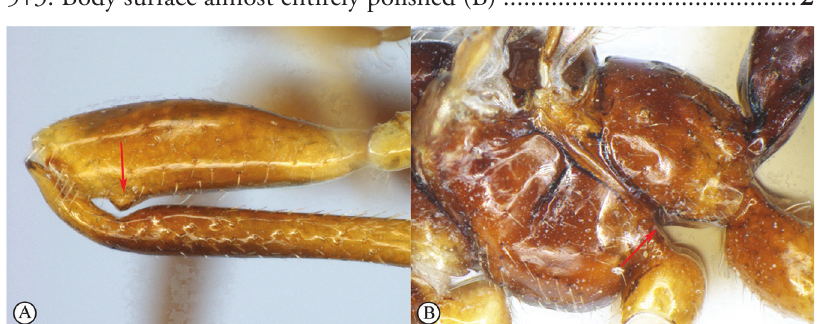
All femora (especially fore femora) with a distinct ventral tooth present sub- apically (A). Metapleural lower lobe indistinct (B). Palpal segment formula